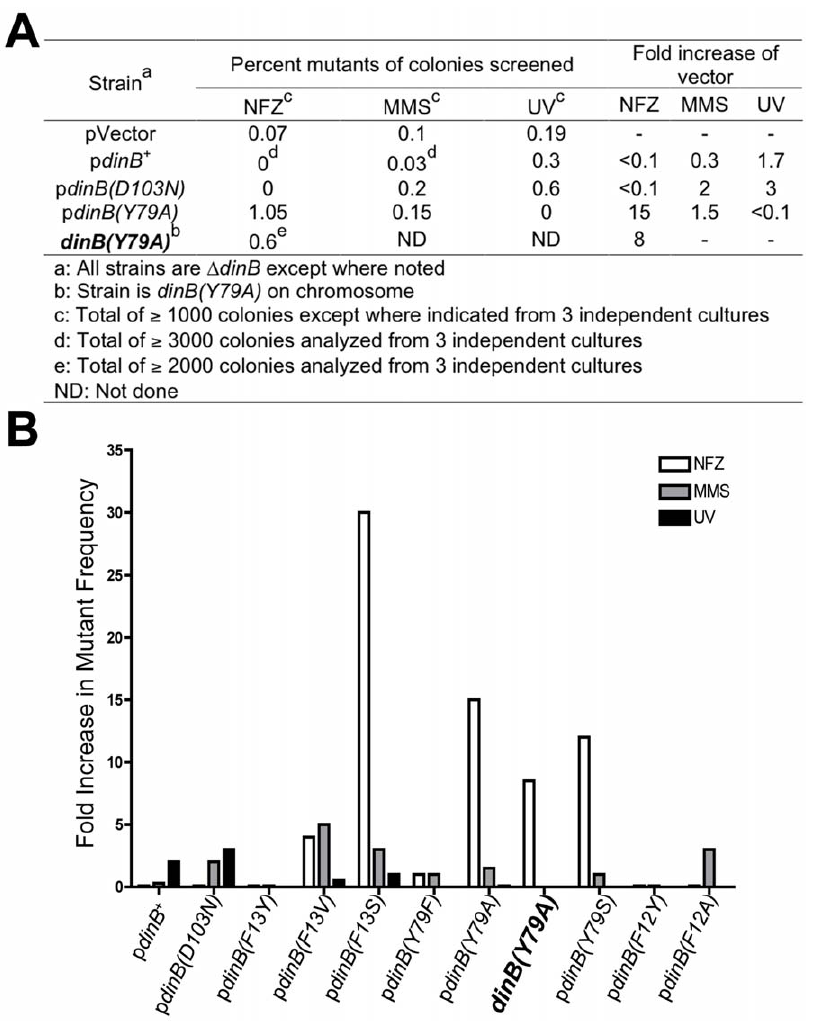
Figure 7. DNA damage-induced mutants. ( A ) D dinB with plasmid-borne DinB variants were treated with MMS (7.5 mM), NFZ (0.008 mM), or UV light (37 J/m 2 ) and screened for mutants unable to grow on glucose minimal medium. Only D dinB strains carrying plasmid-borne dinB + , dinB(D103N) , dinB(F13V) , dinB(F13S) , or dinB(Y79A) alleles were assessed for UV-induced mutants. NFZ-induced mutants were also ascertained in the dinB(Y79A ) strain in which the DinB variant is expressed from the chromosome (bold font). Mutants were equally distributed when independent cultures were analyzed. All samples have a standard error # 5% of the average of mutants obtained per individual culture. ( B ) The fold difference shown in mutants is relative to D dinB